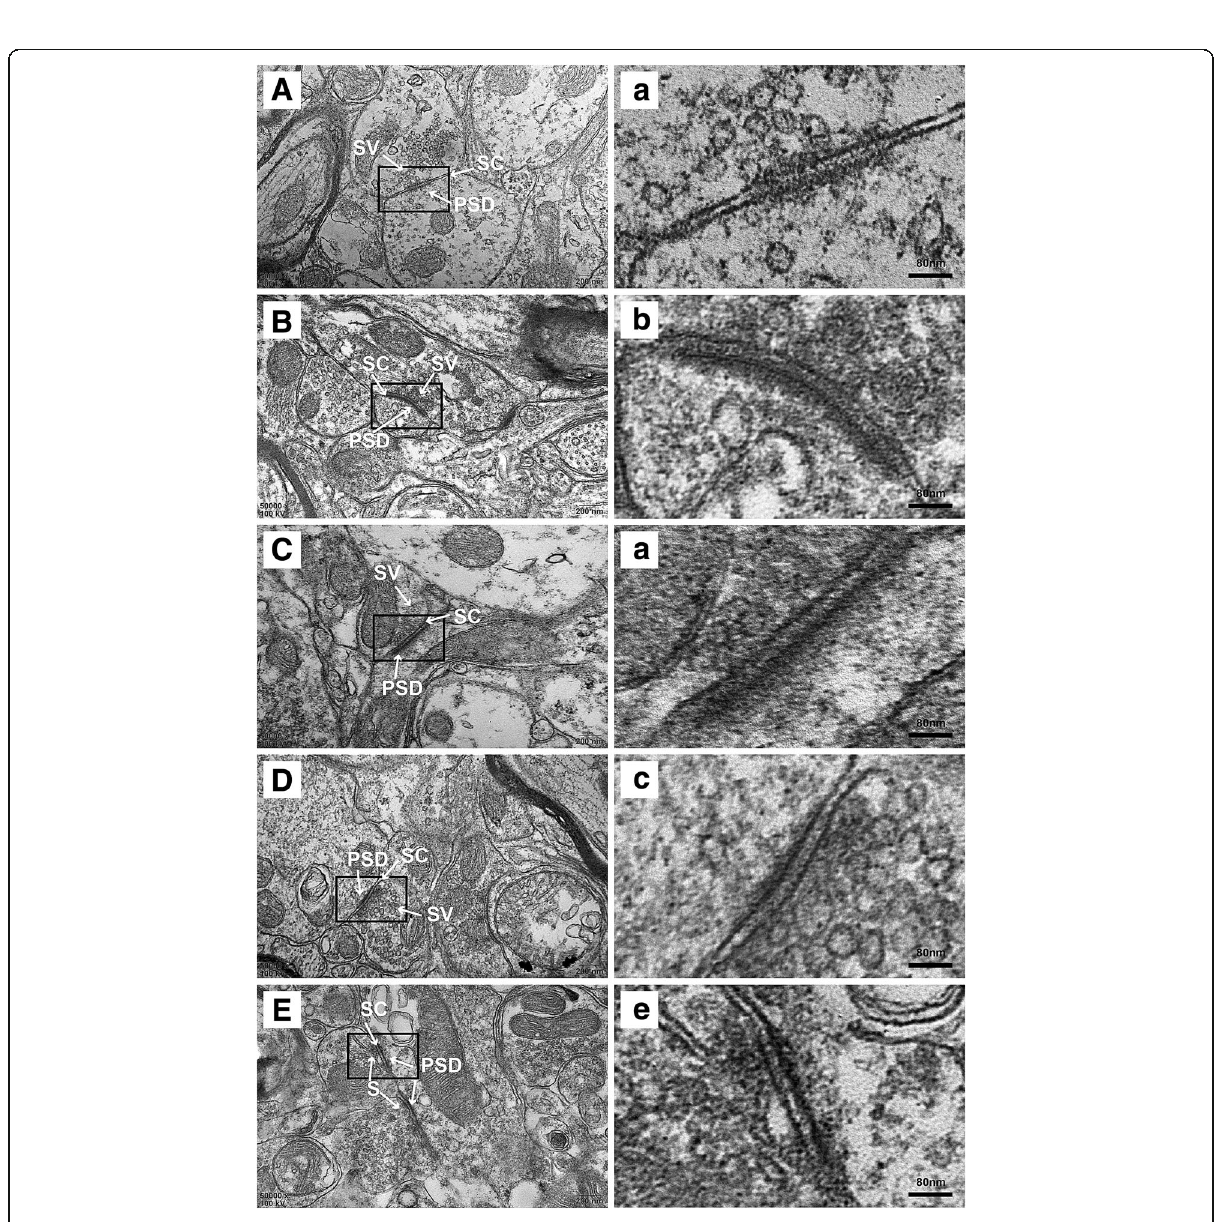
Fig. 7 Synaptic structure of the TNC neurons in each group. a , a : sham group; b , b : CM group; c , c : CM + DMSO group; d , d : CM + PP2 group; e , e : CM + genistein group. PSD, postsynaptic density; SC, synaptic cleft; SV, synaptic vesicle. a - d show enlarged versions of the images in a - d . Scale bars = 200 nm ( a - d ). Scale bars = 40 nm ( a - d